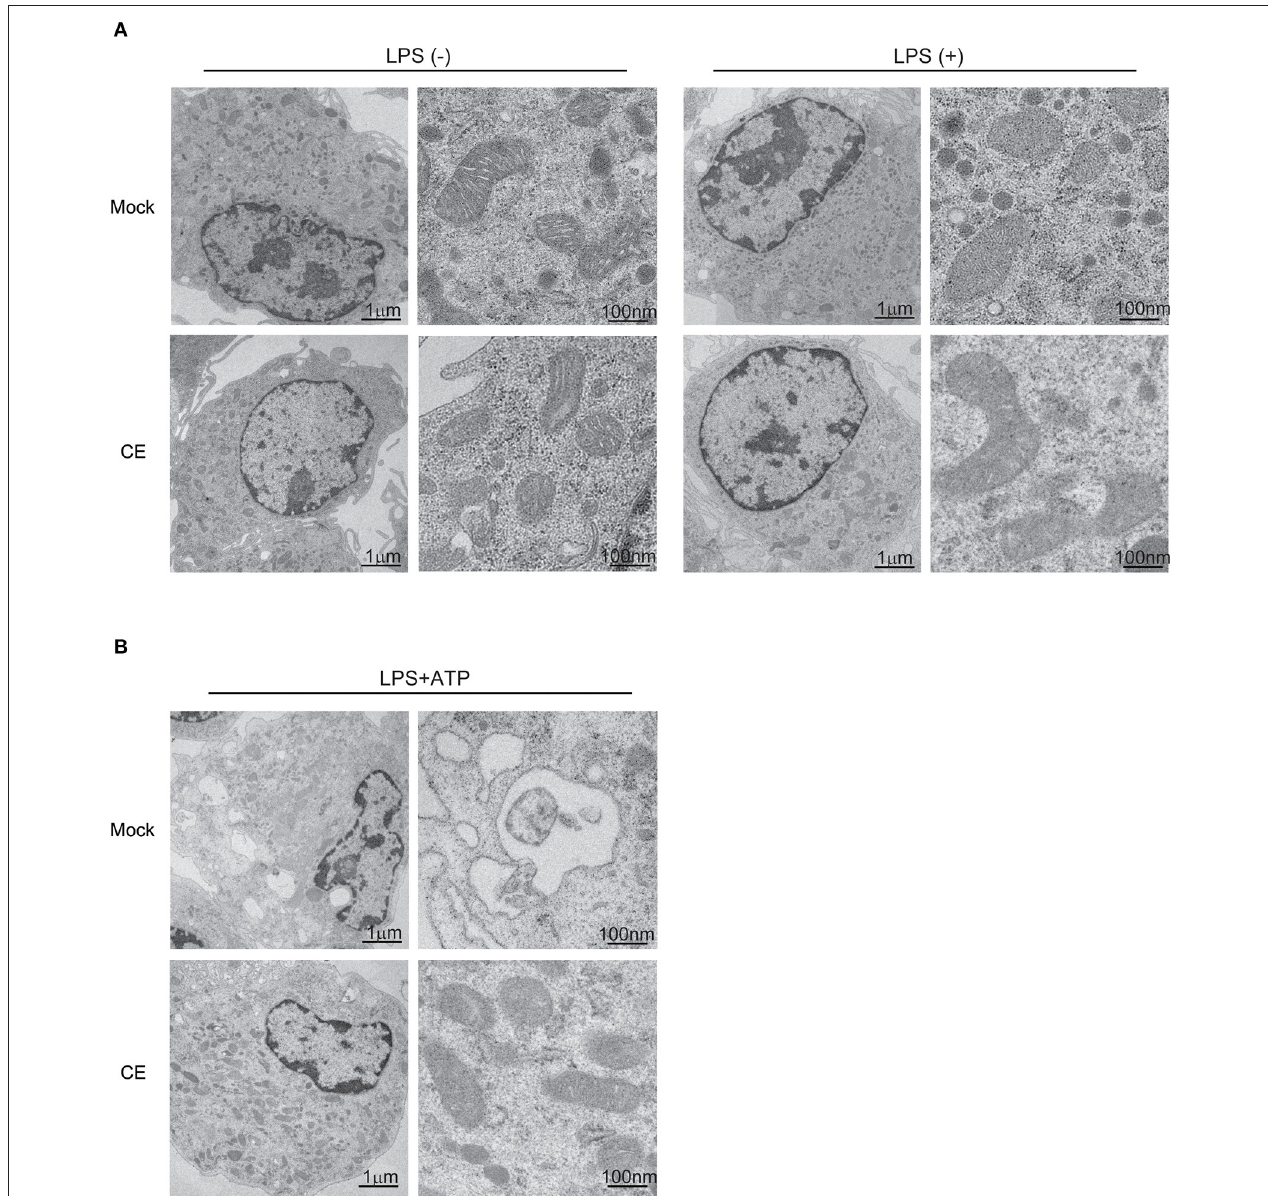
FIGURE 5 | Electron microscope image in murine macrophages. (A,B) Electron microscopy images of BMDMs. The images on the right highlight individual